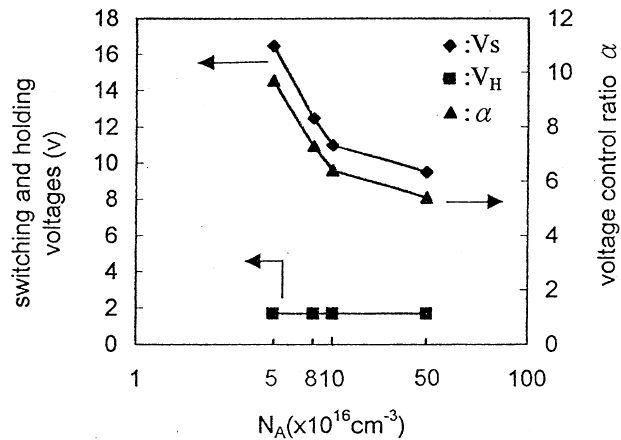
FIGURE 3 The switching voltages, holding voltages and voltage control ratios as a function of epitaxial doping concentrations. The switching voltages and voltage control ratios decrease with increasing